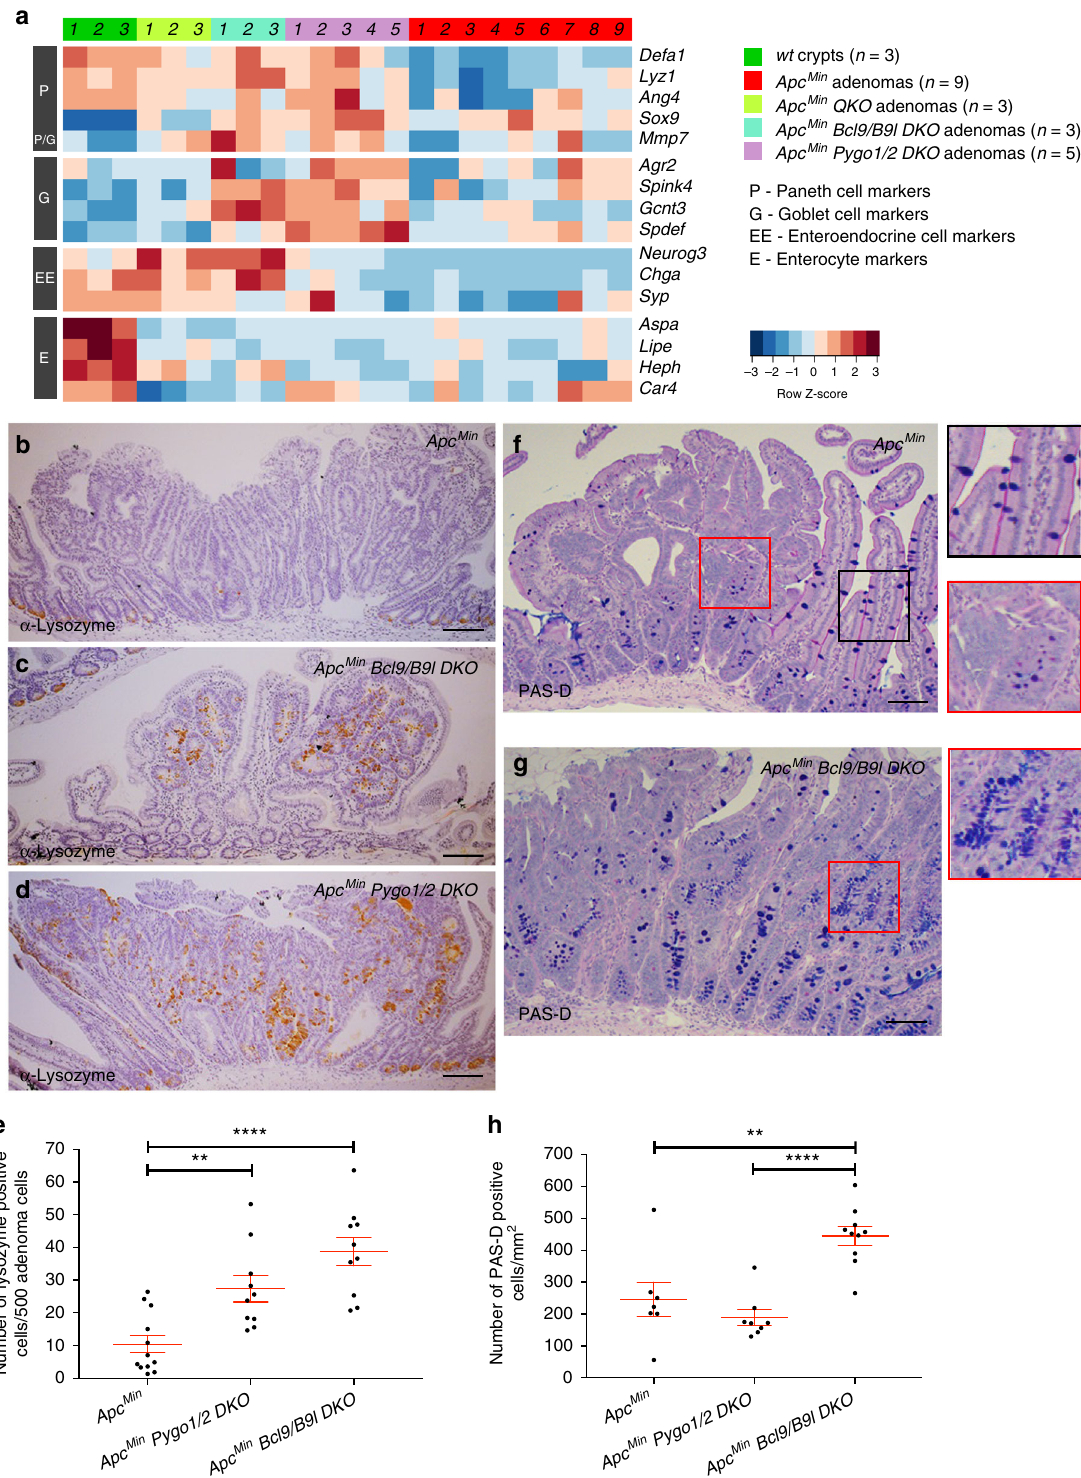
Fig. 4 Loss of Bcl9 or Pygo causes a shift towards secretory cell fates in adenomas. a Heat map (as in Fig. 2b) for selected differentiation markers, as indicated on the right. b – g Sections through adenomas (genotypes indicated in panels) stained for ( b – d ) Paneth ( brown , α -lysozyme) or ( f , g ) goblet cells ( dark blue , PAS-D); right , magni fi ed views of squares in ( f , g ), with strong PAS-D signals in villi ( black square ) or adenomas ( red squares ) indicating mature or immature goblet cells, respectively; purple , hematoxylin; scale bar, 100 μ m. e , h Quanti fi cation of ( b – g